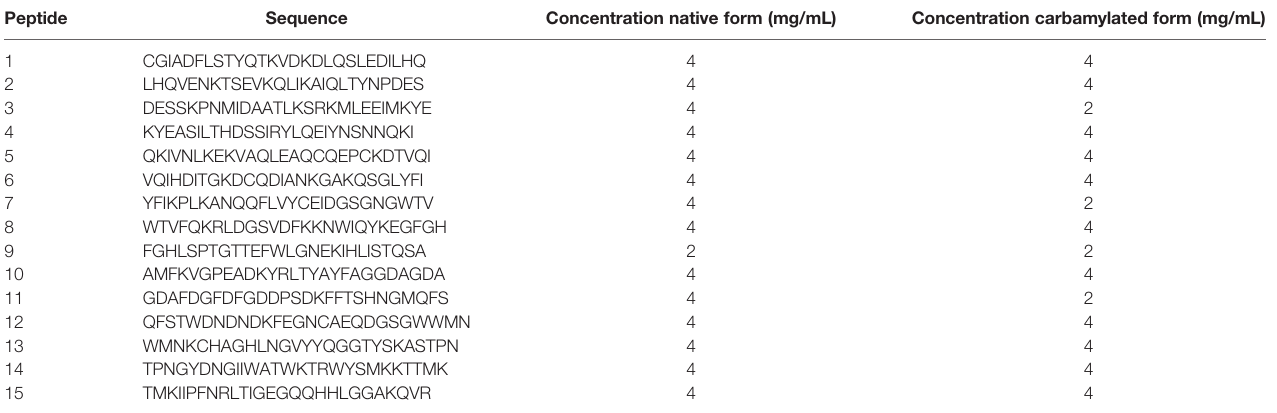
TABLE 1 | Native or carbamylated peptides of fi brinogen g chain (27 mer-straddling 3 amino acids) containing at least one lysine. Peptide